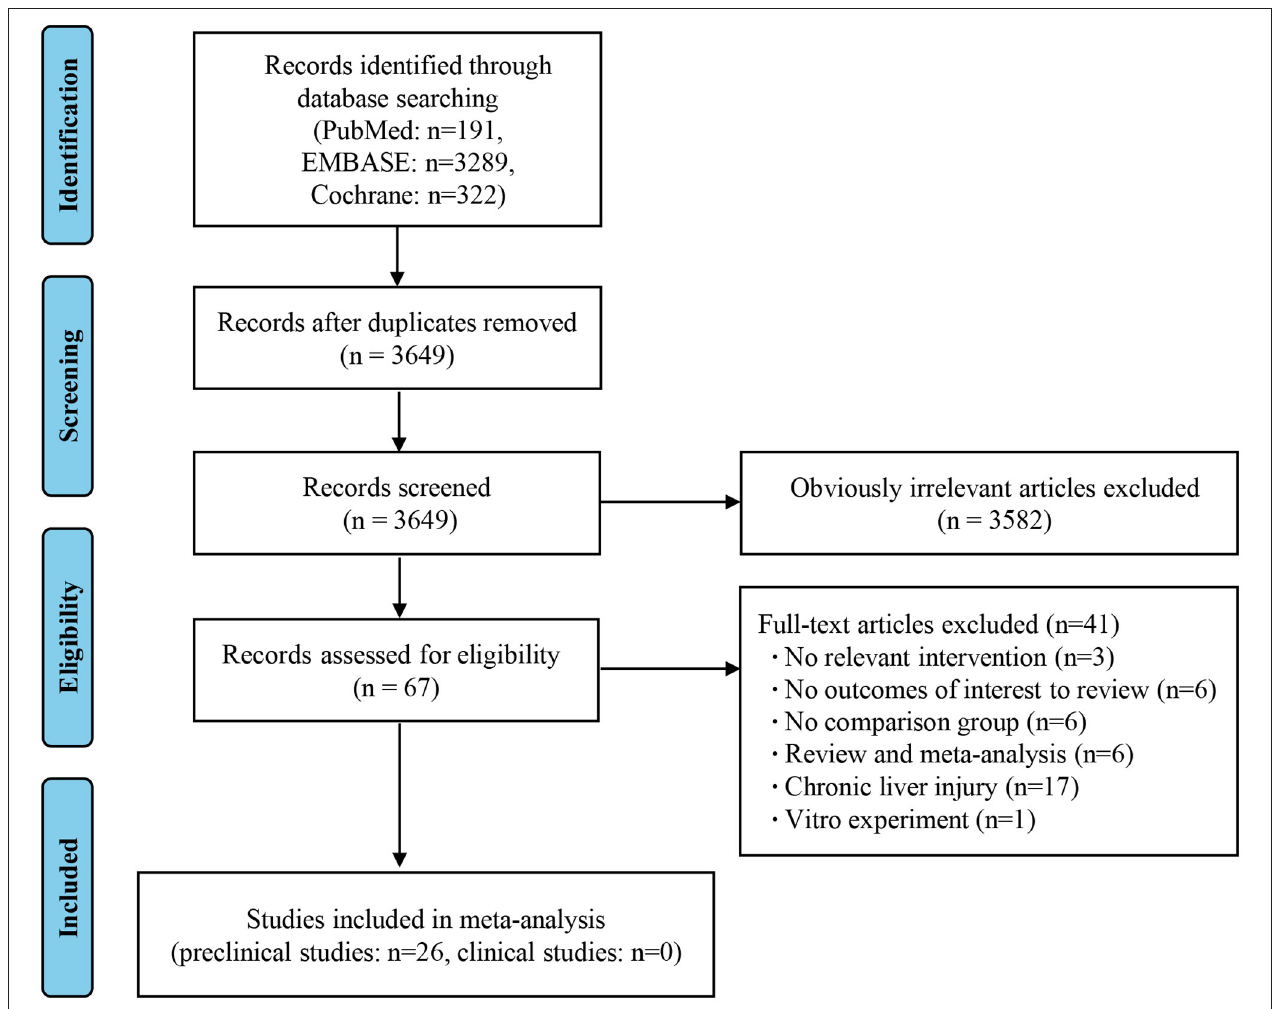
FIGURE 1 | Flow diagram based on the Preferred Reporting Items for Systematic Reviews and Meta-Analyses (PRISMA).